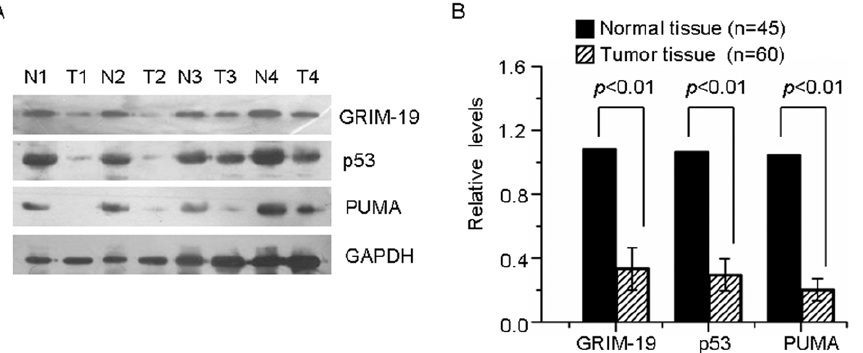
Figure 1. A correlation between the loss of GRIM-19 and p53 proteins in primary cervical cancers. ( A ) Total cellular extracts (50 m g) from primary cervical tumors (T) and normal cervical tissues (N) were examined for the expression of GRIM-19, p53 and PUMA by Western blotting. The representative results of Western blotting are shown. T1-T4 was from individual patients with cervical cancer. T1 and T2 were diagnosed as stage IIa; and T3 and T4 were diagnosed as stage Ia squamous epithelial carcinomas. ( B ) Quantitative analysis of the protein expression as measured by the optical density of each band. The ratio of the density from GRIM-19, p53, PUMA over the corresponding GAPDH (45 cases of normal tissue and 60 cases of tumor tissue) was calculated.